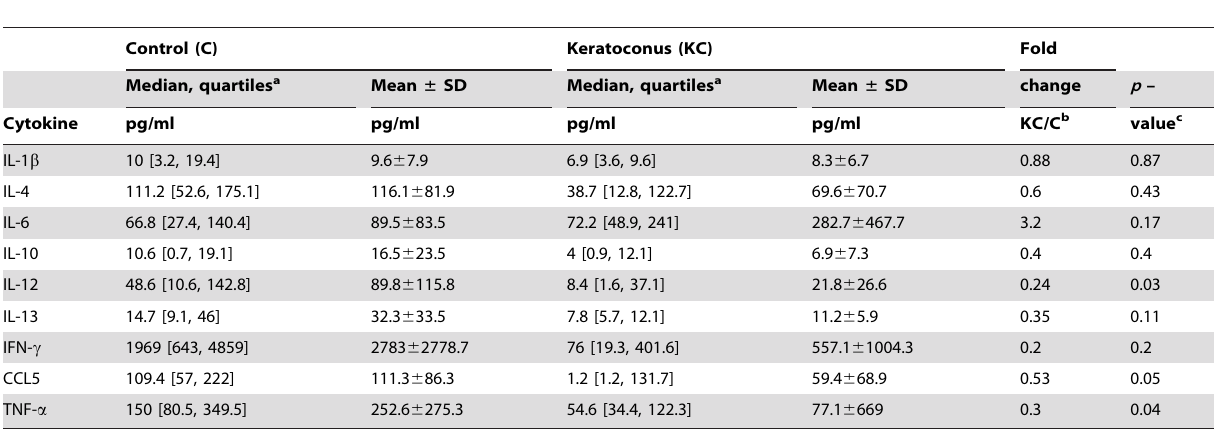
Table 2. Tear-fluid cytokine concentrations in keratoconus and control